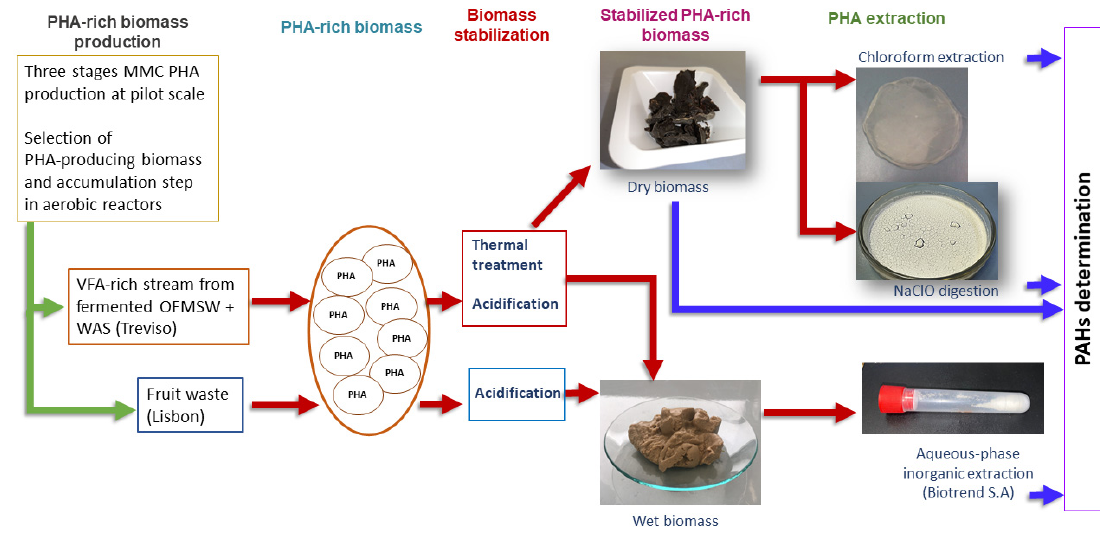
Figure 3. Schematic description of the analyzed samples.